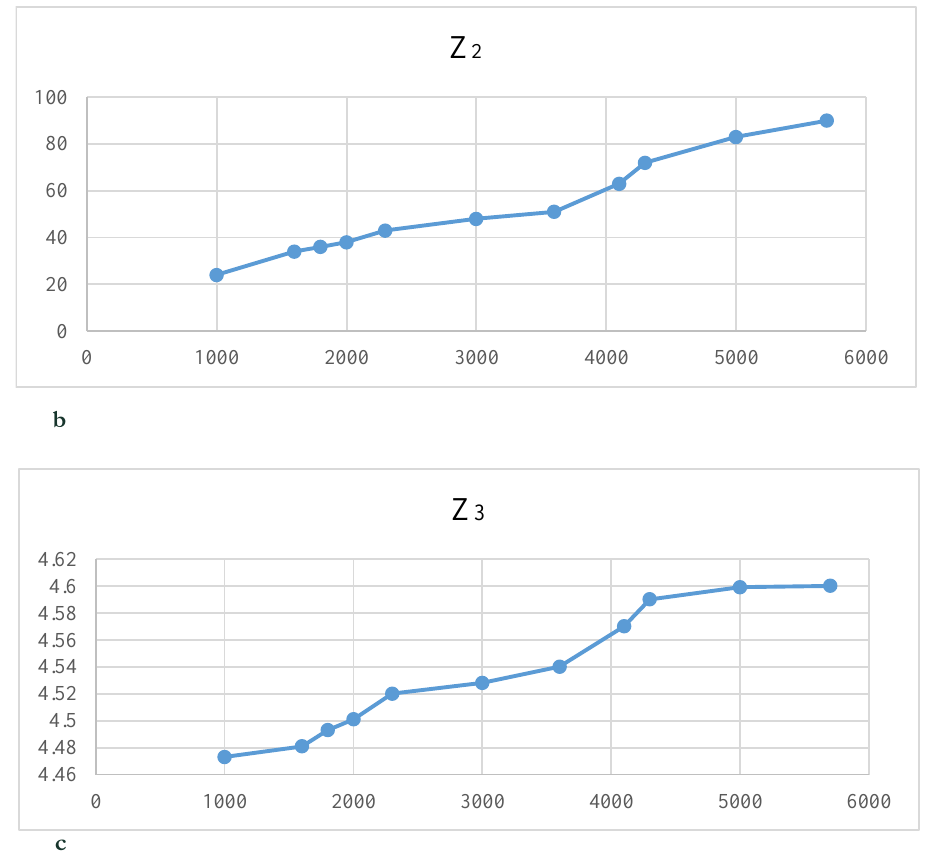
Fig. 5. The effect of D parameter on objective